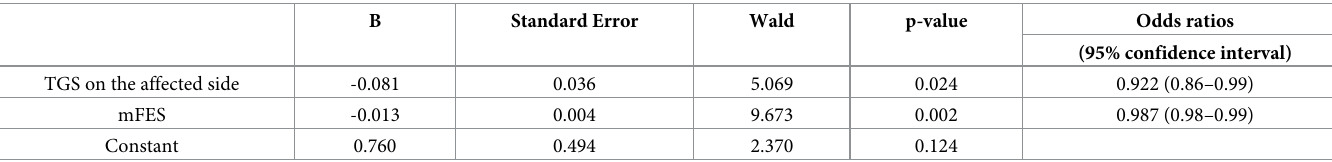
middle-aged adults and, whose average age was 62.02, divide them into high and low risk of falls. They found TGS to be an independent risk factor for fall occurrence [40]. However, there is no report on whether reduced TGS in individuals with KOA is associated with the fall itself. Based on the results of our study, we believe that TGS contributes to the challenges faced by older adults with KOA and a fall history. Although a detailed causal relationship is unknown, multiple regression analysis has identified TGS as an independent factor associated with KOA [41]. Conversely, abnormal loading of the knee joint can be caused by changes in the kinematic relationship between the foot and knee [42, 43]. Compared to healthy older adults, those with KOA have lower TGS, and the measured pressure decreases during walking [44, 45]. It is pos- sible that the progression of KOA leads to decreased TGS; conversely, decreased TGS may con- tribute to KOA progression. However, this causal relationship is unclear; therefore, further studies are required to investigate it. Regardless of the causal pathway, there is interdepen- dence between TGS and KOA, which increases the risk of falls. In the future, studies should Table 2. Results of the multiple logistic regression analysis. B